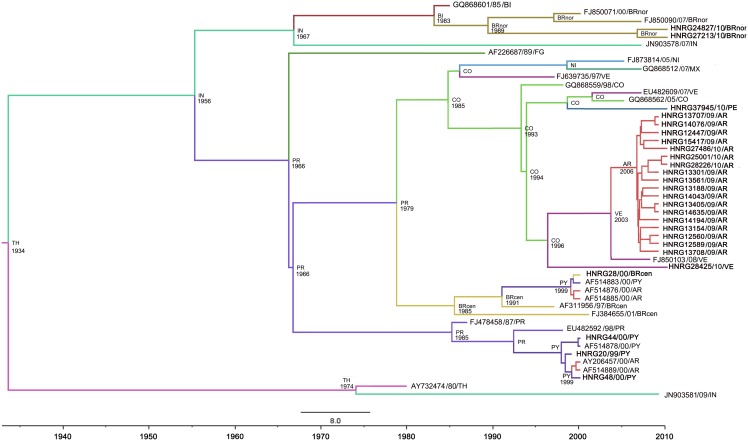
Most clade credibility tree obtained by a discrete phylogeographic analysis of DENV-1 genotype V.The probable country location and age of the ancestors are shown on the nodes (5E+8 generations sampling every 5E+4). Sequences included in the analysis are noted as GenBank accession number/collection date/source country for sequences downloaded from GenBank, and as HNRGnumber/collection date/source country for sequences obtained in our laboratory. Abbreviations of the countries are as follows: AR: Argentina, BI: British Virgin Islands, BRcen: Center of Brazil, BRnor: North of Brazil, CO: Colombia, FG: French Guiana, IN: India, MX: Mexico, NI: Nicaragua, PE: Peru, PR: Puerto Rico (USA), PY: Paraguay, TH: Thailand, VE: Venezuela.